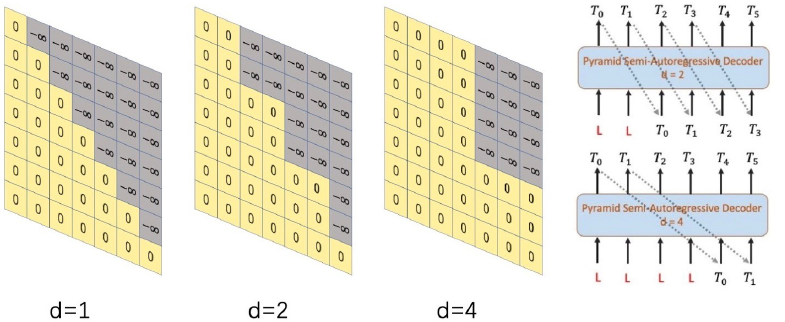
Figure 3. Relaxed mask. When d = 1, it is actually equivalent to the restricted self-attention. d = 2 means the divided level is 2 and two frames in a group. d = 4 means the divided level is 4 and four frames in a group. The vertical axis represents the position of the target vocabulary, and the horizontal axis represents the viewable